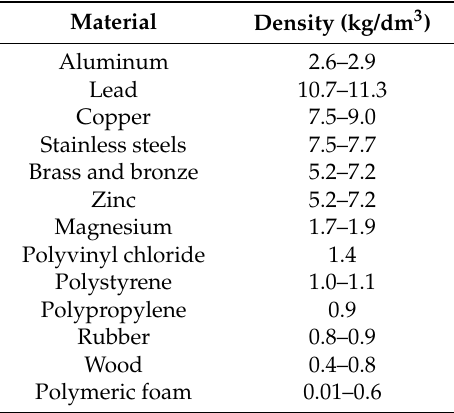
Table 3. Densities of aluminum and contaminant materials [39].